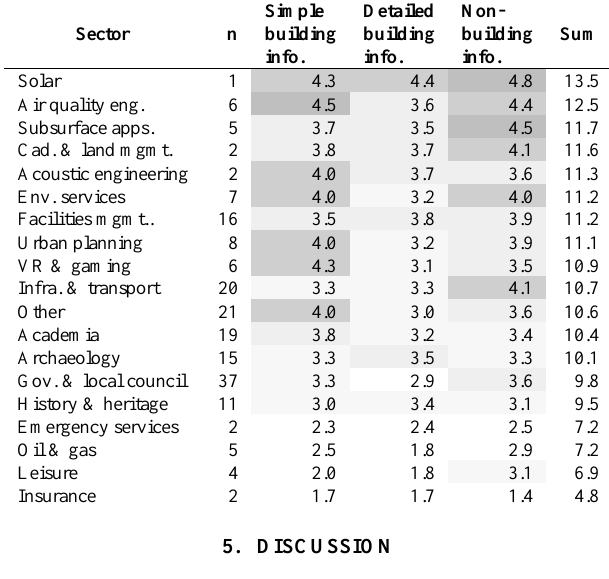
Table 6. Median response for UK participants split by factor and sector, sorted by the